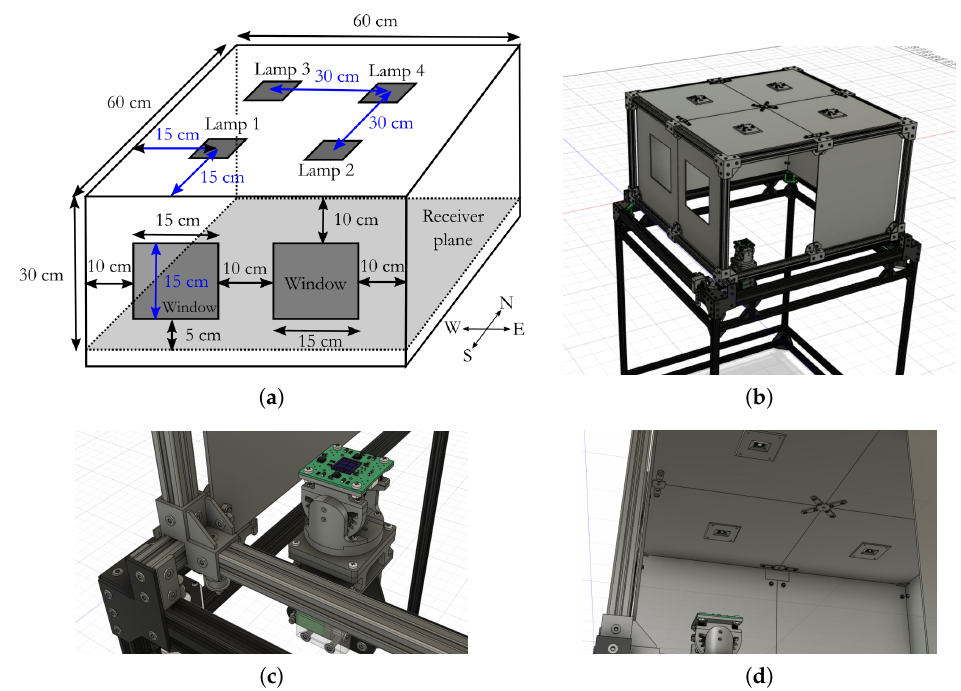
Figure 2. Mockup design: ( a ) Mockup scheme. ( b ) View of the mockup design. ( c ) Zoom of receiver. ( d ) Zoom of emitters at ceiling.